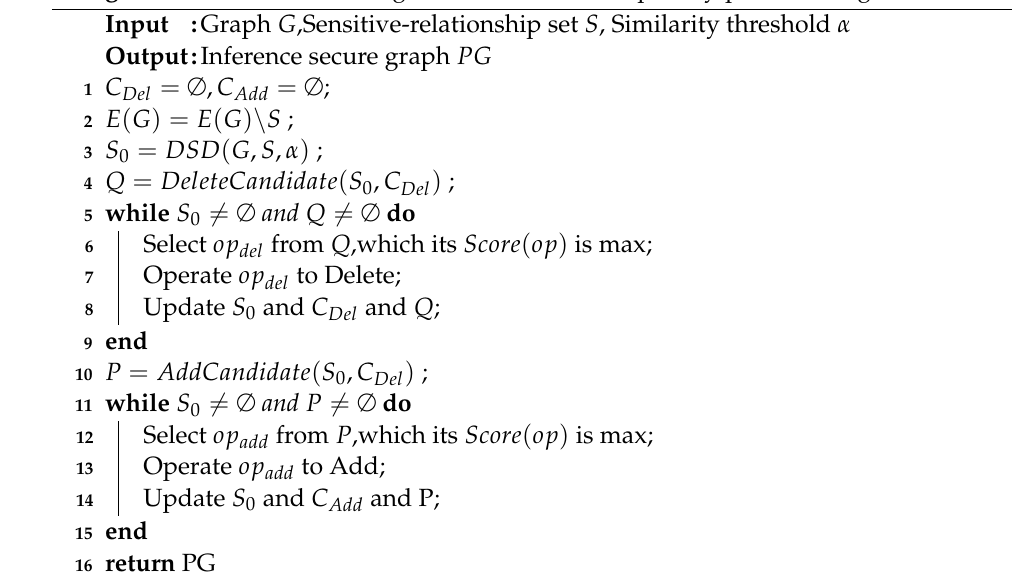
Algorithm 1: Location-visiting-characteristics-based privacy-protection algorithm